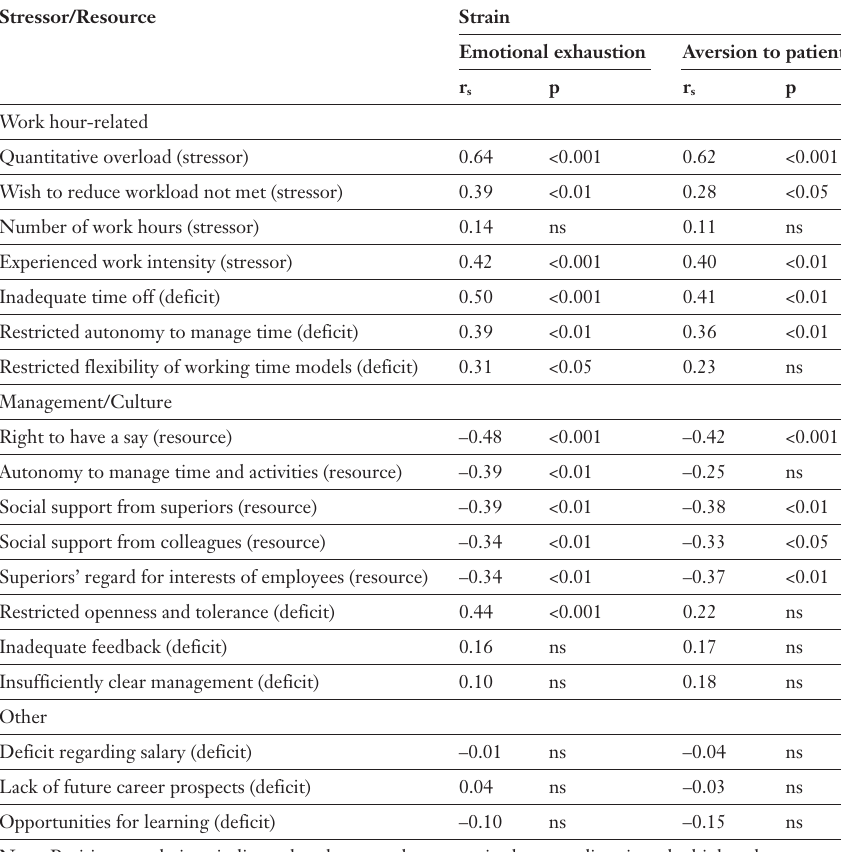
Stressors and strains: Correlations between results of the analy- sis for residents and chief residents (Spearman’s correla- tion coefficient